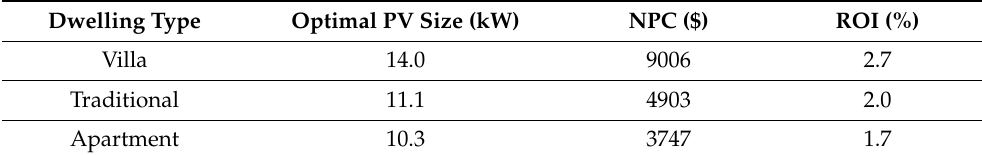
Table 4. Optimal size of solar PV system for residential buildings assuming tariff of 0.08 $/kWh. Dwelling